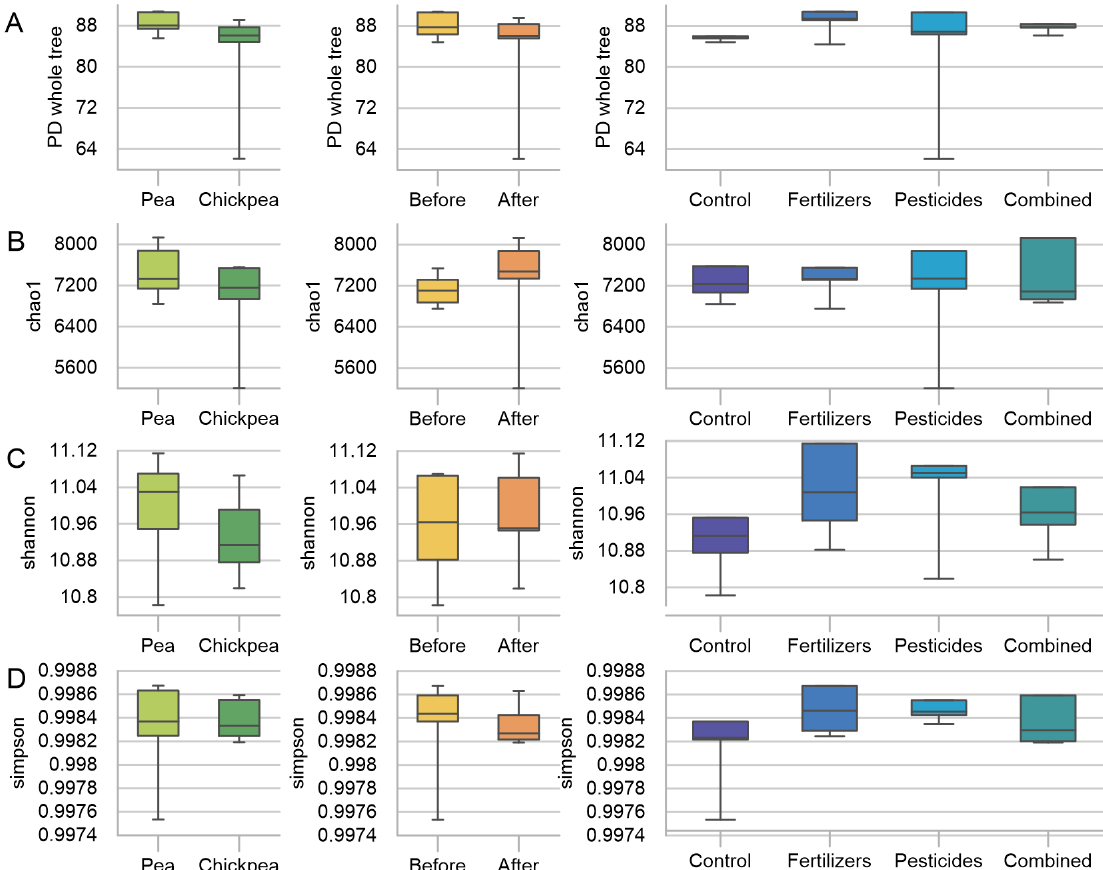
Figure 3. Effect of experimental conditions on α-diversity indices: phylogenetic distance metric ( A ), Chao1 ( B ), Shannon ( C ), and Simpson ( D ). The ends of the whiskers represent the minimum and maximum, the box edges are quartiles, and the central line is the median. No significant differences were observed for the group comparisons based on Mann-Whitney U Test and Kruskal-Wallis ANOVA.